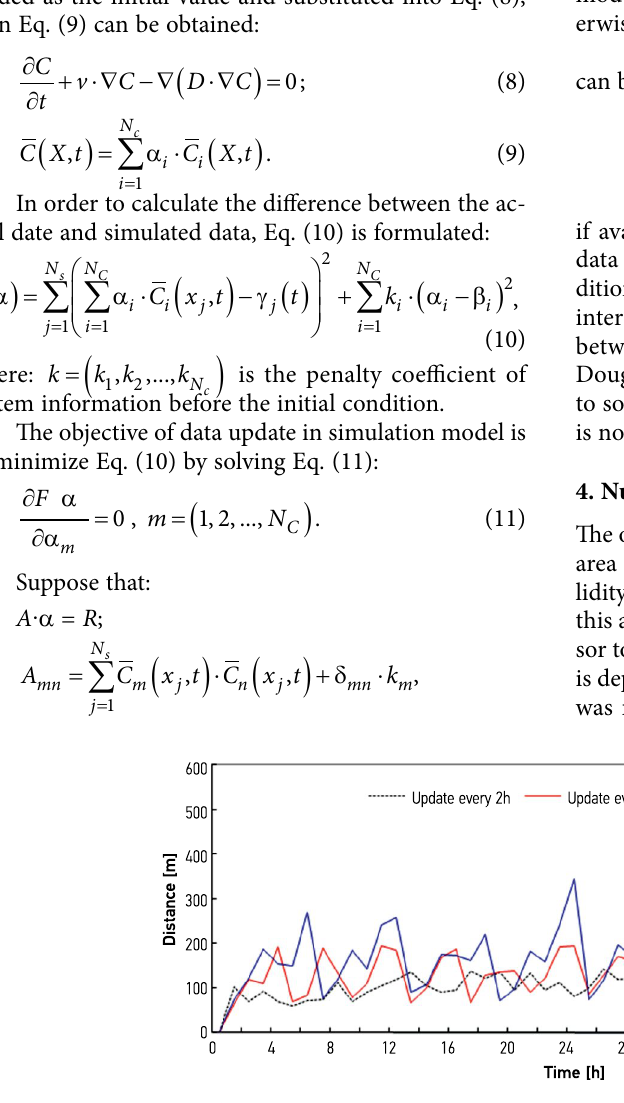
Fig. 3. The distance of central drift trajectory between DDDAS-based model and real case